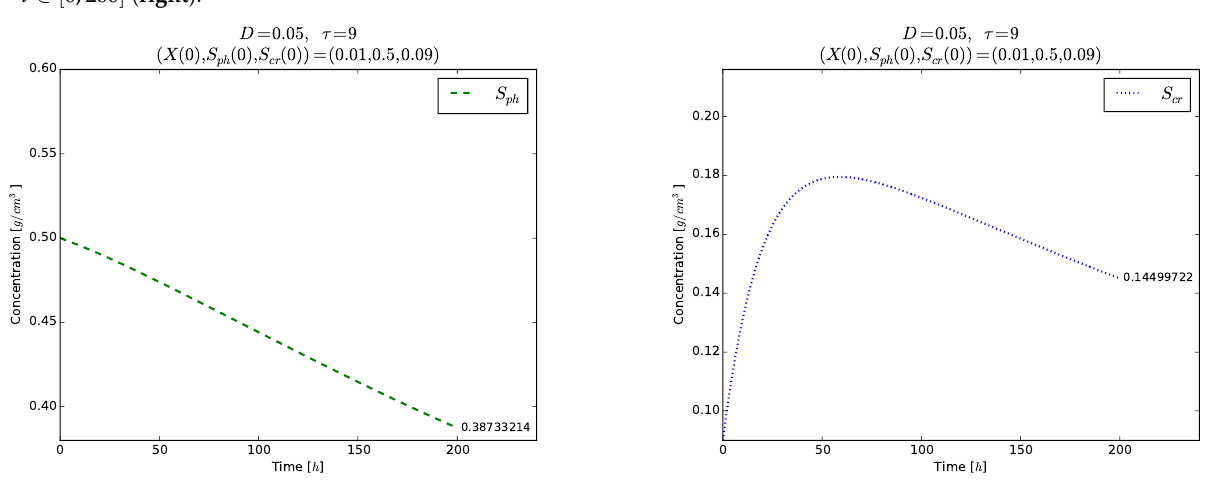
Figure 7. Example 2. Time evolution of the phase variables S ph ( t ) ( left ) and S cr ( t ) for t ∈ [ 0,200 ] ( right